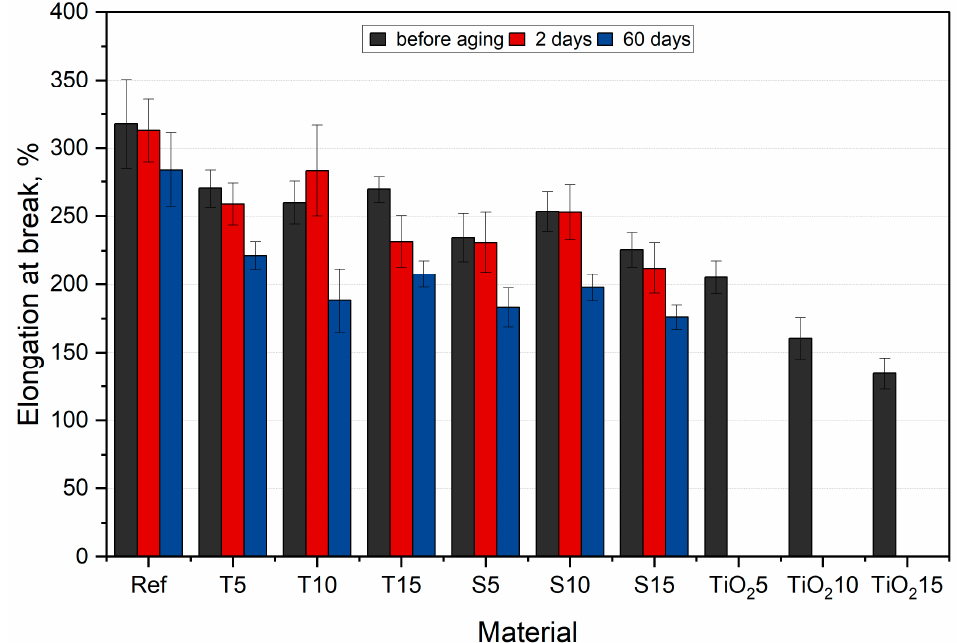
Figure 17. Elongation at break results, along with reference data from [55].